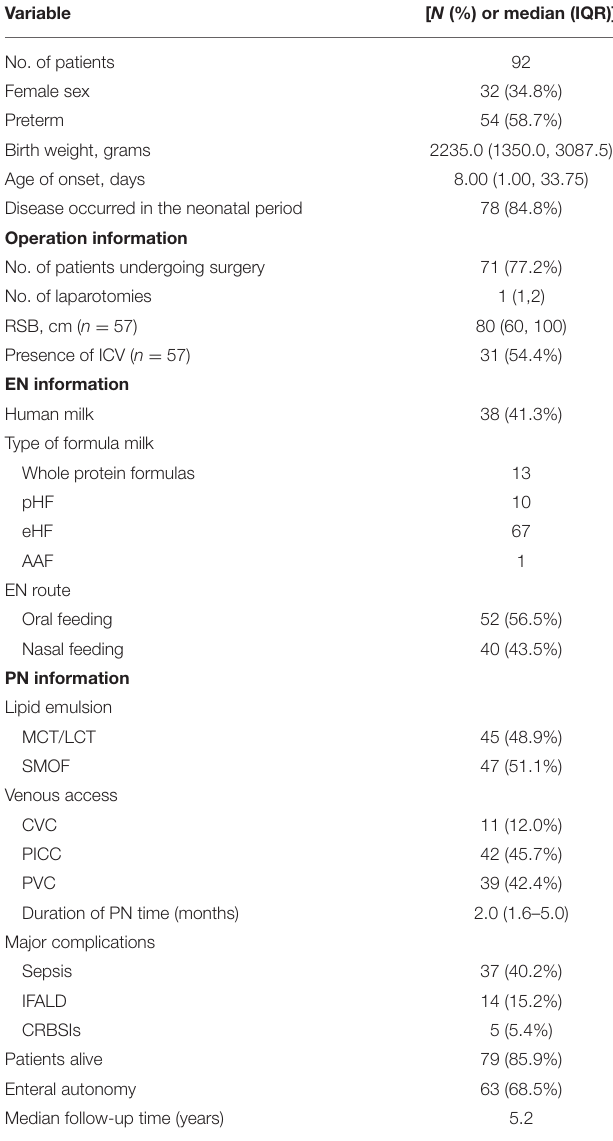
TABLE 1 | Descriptive statistics of the study